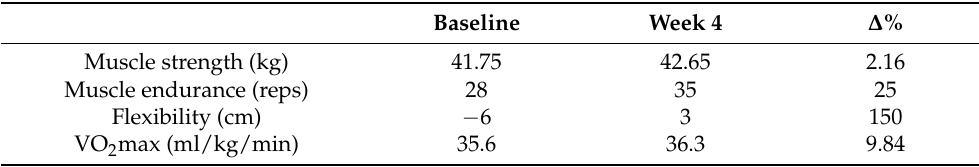
Table 5. Changes in health physical fitness